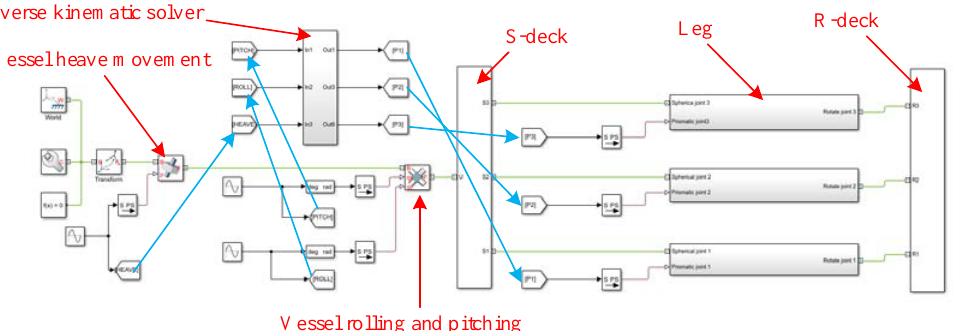
Figure 21. Diagram of simulation in Simulink.